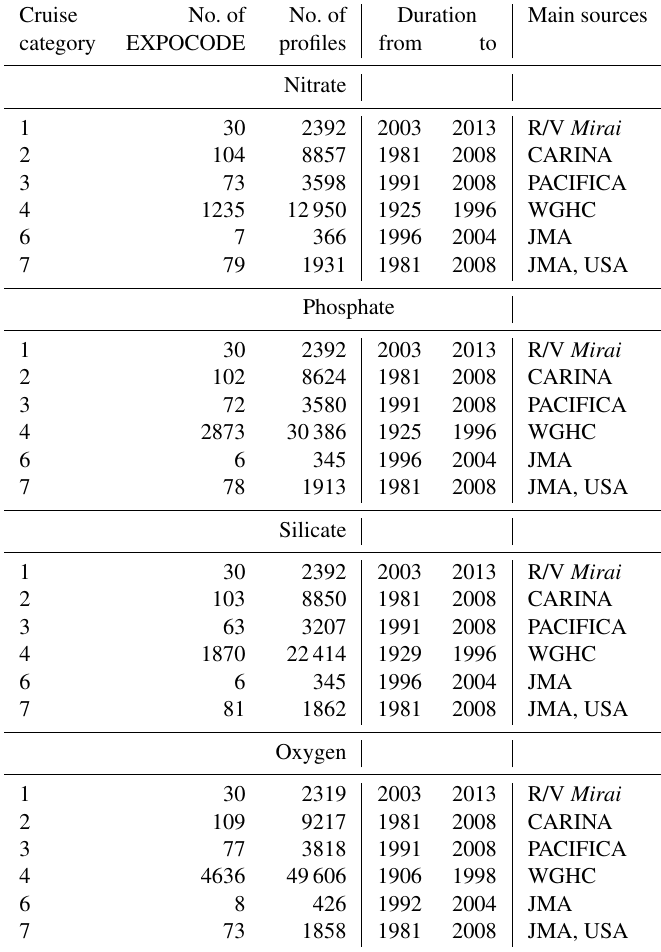
Table 1. Summary of data collected and used in this study. Cruise No. of No.